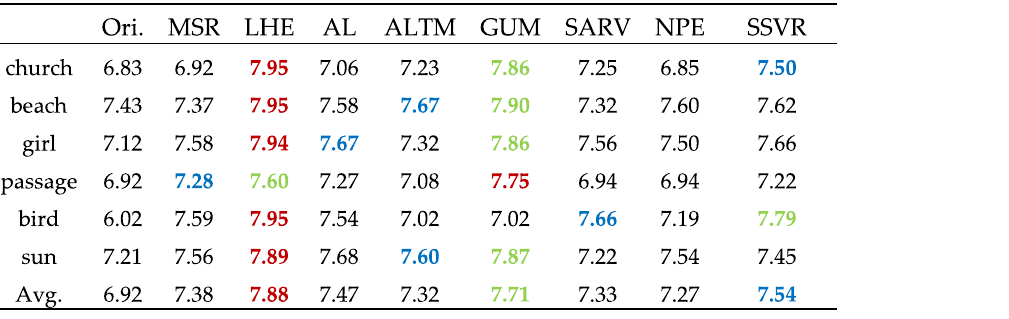
Table 2 Discrete entropy of compared